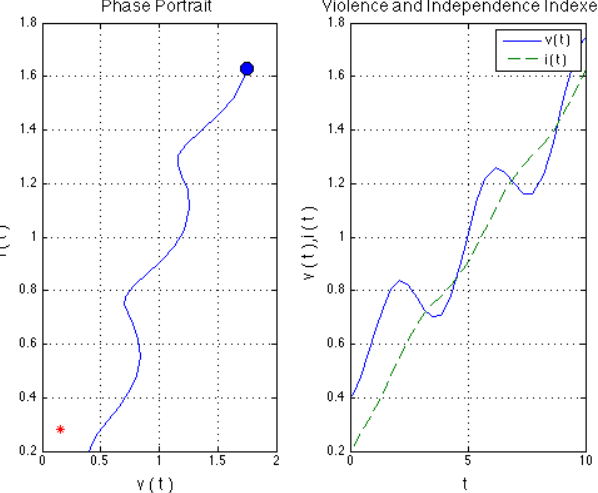
Figure 5. Violent man with alcohol consumption, empowered woman. α 1 = 0.5, α 2 = 0.6, β 1 = 0.3, β 2 = 0.3, γ = 0.6, δ 1 = 0.25, δ 2 = 0.25, ρ 1 = 0.5, ρ 2 = 0.5, µ = 0.6, ρ = 0.25, ω = π /2, η =